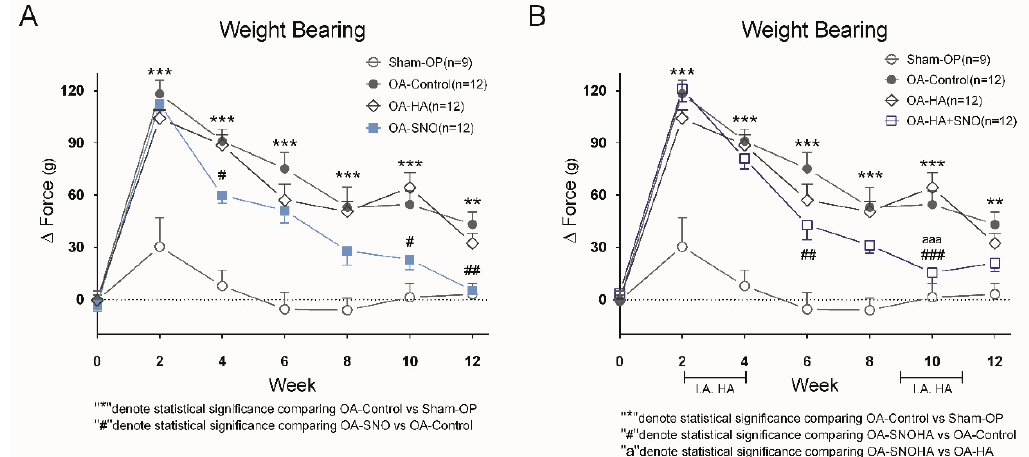
Figure 3. Weight bearing test of the OA rats. ACLT + MMx was performed to induce knee OA at week 0, and di ff erent treatments were given according to the experimental design. ( A ) Biweekly weight-bearing measurements of the sham-OP, OA-control, OA-HA, and OA-SNO rats. ( B ) Biweekly weight-bearing measurements of the sham-OP, OA-control, OA-HA, and OA-SNOHA rats. The data are presented as the ∆ Force (g) and expressed as the mean ± SEM and two-way ANOVA, and Sidaks’s multiple comparisons test were used to analyze the data. # p < 0.05, ## / ** p < 0.01, aaa / ### / *** p < 0.001.